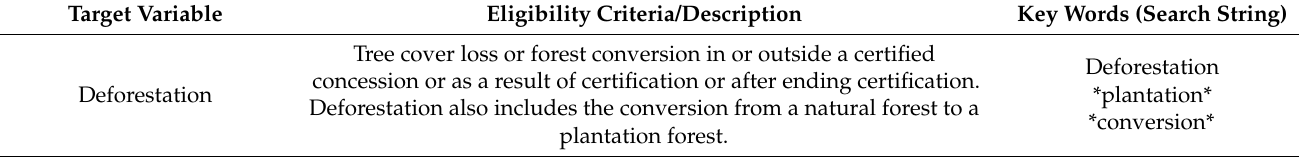
Table 2. Eligibility criteria and key words used to compile the search string. The truncation symbol (*) behind/before a word stem ensures that other word forms can be retrieved, e.g., carbon* = carbon sequestration, carbon emissions, or *plantations = forest plantations,